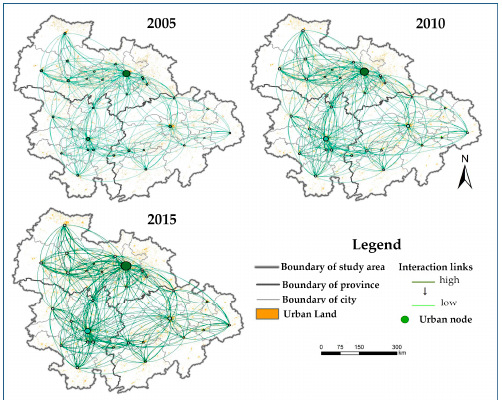
Figure 3. Interaction network in the urban agglomeration in the middle reaches of the Yangtze river in China. Table 2. Degree centrality of each city in the MYR-UA.